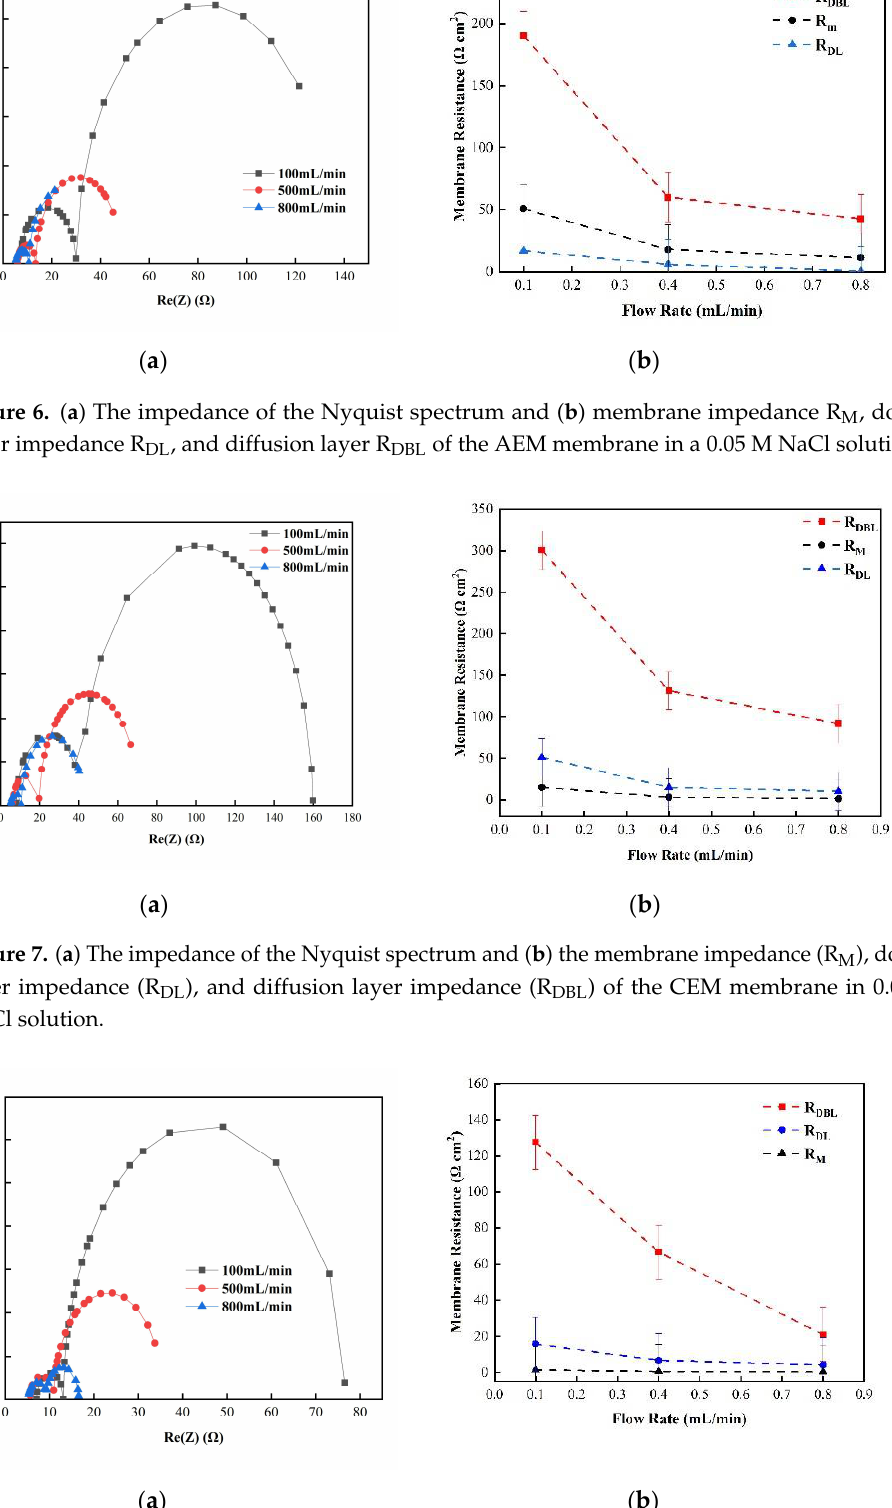
Figure 8. ( a ) The impedance of the Nyquist spectrum and ( b ) the membrane impedance R M , dou- ble layer impedance R DL , and diffusion layer impedance R DBL of the FO membrane in 0.05 M NaCl